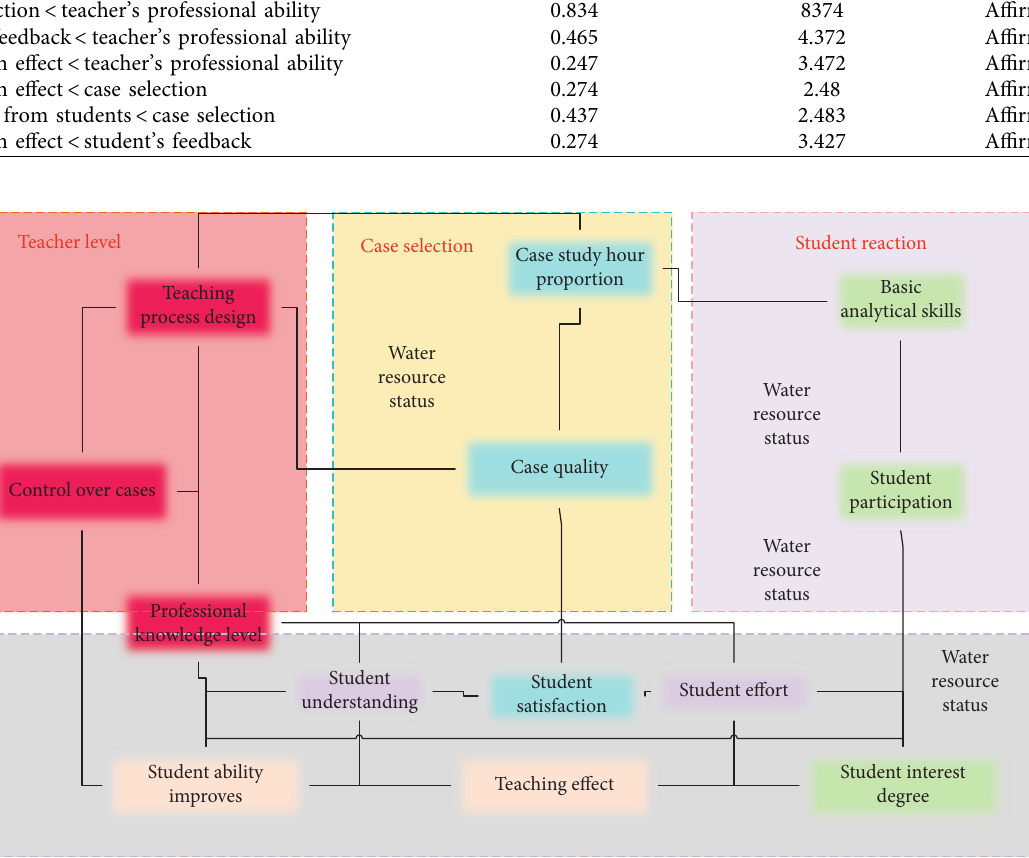
Figure 6: The structure equation model and specific path parameters of case teaching effect